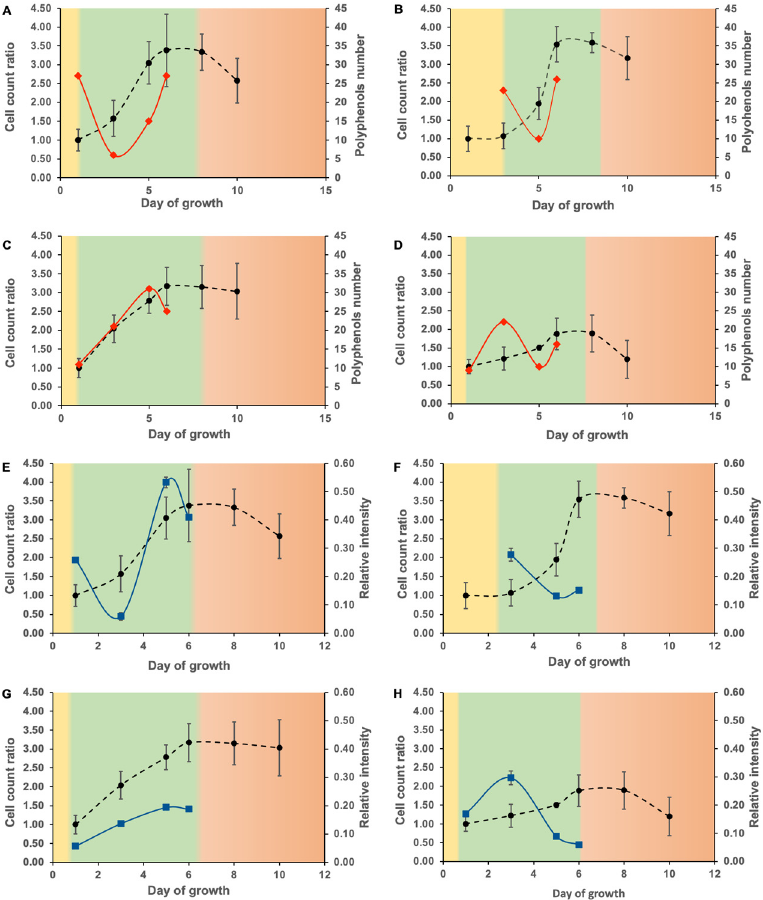
Figure 3. Cellular growth curve (black), number of molecular formulas (blue) and their relative intensities (red) attributed during the log phase with ( A , E ) glutamic acid, ( B , F ) glucose, ( C , G ) malic acid and ( D , H ) GSH amendment. The lag, log and stationary phases are shown in yellow, green and orange, respectively.